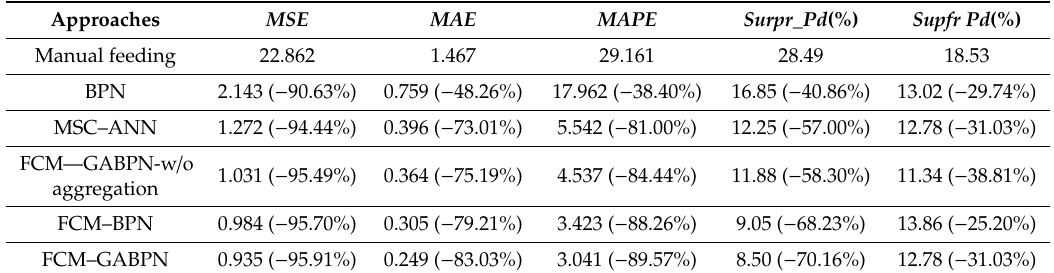
Table 5. Improvement of di ff erent approaches comparing to comparison basis—manual